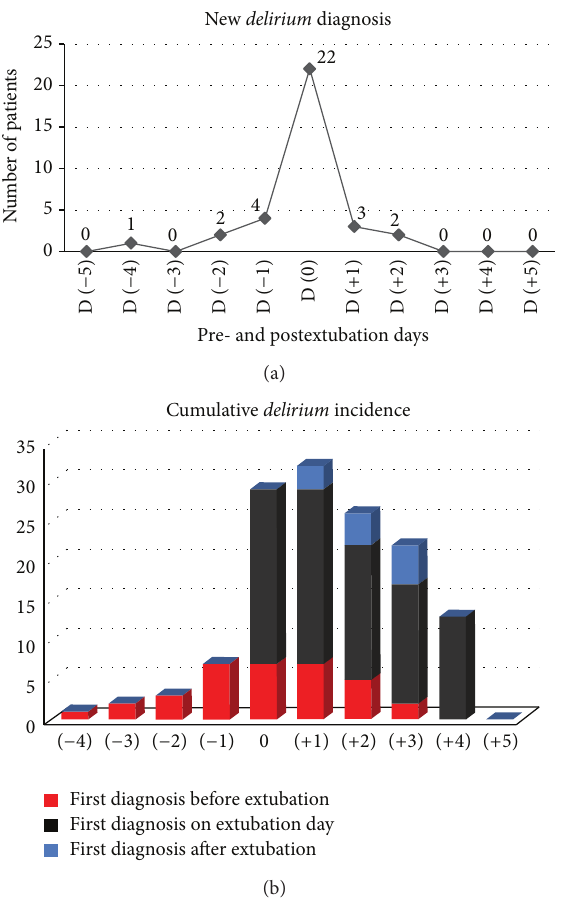
Figure 2: (a) Incidence of new-diagnosed delirium according to extubation day (D 0); (b) cumulative delirium incidence.